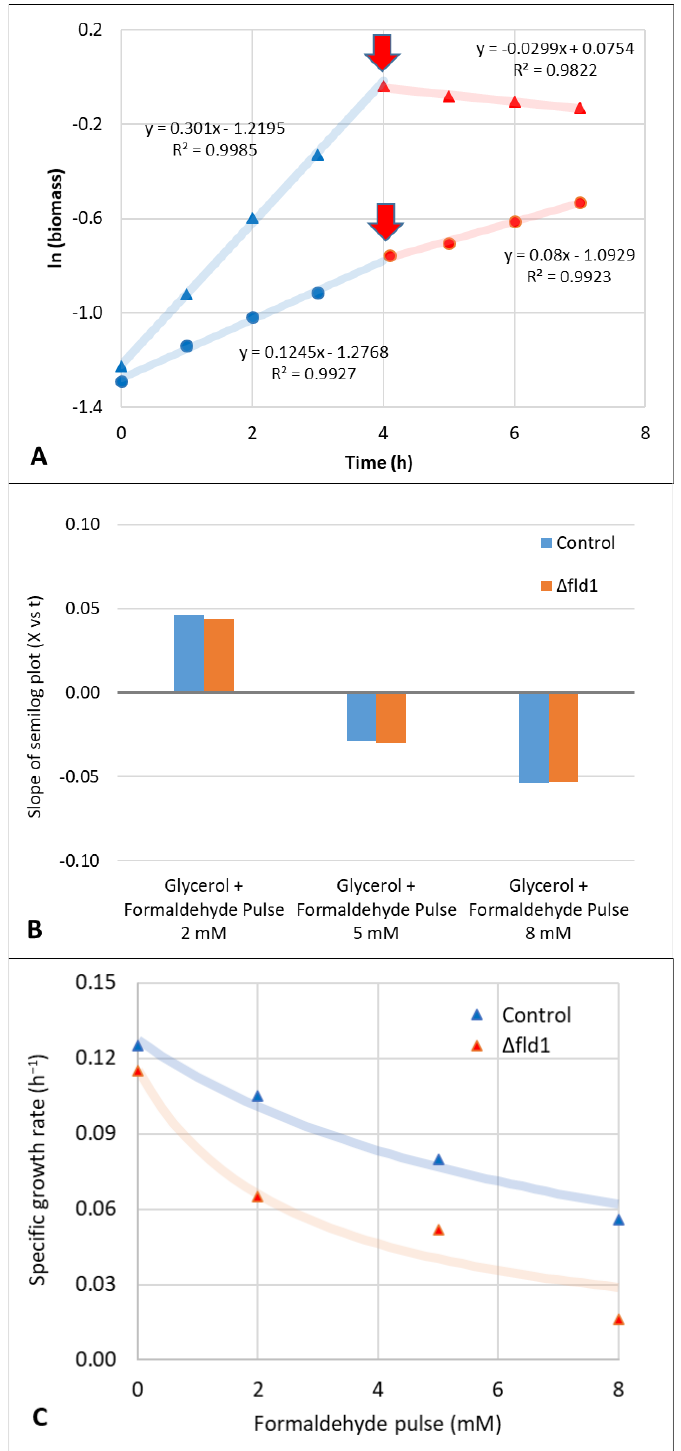
Figure 3. ( A ) Example of biomass growth kinetics (shown as ln X ) of control strain with glycerol (triangles) or methanol (circles) as the carbon source. The growth behaviour before (blue symbols) and after (red symbols) a formaldehyde pulse (5 mM) performed after 4 h of inoculation (red arrow) is shown. The experimental error in biomass measurements was lower than 3% (not shown). ( B ) The effect of formaldehyde pulses (2, 5 and 8 mM) on the cell growth kinetics (slope of semi log plot) of control (blue) and ∆ fld1 (orange) strains using glycerol as the only carbon source. ( C ) The compared effect of formaldehyde pulses (2, 5 and 8 mM) on control (blue triangles) and Δ fld1 (red triangles) strains using methanol as the only carbon source. Model adjustment Equation (5) is also shown with continuous lines for each strain. SEM < 5% (not shown).